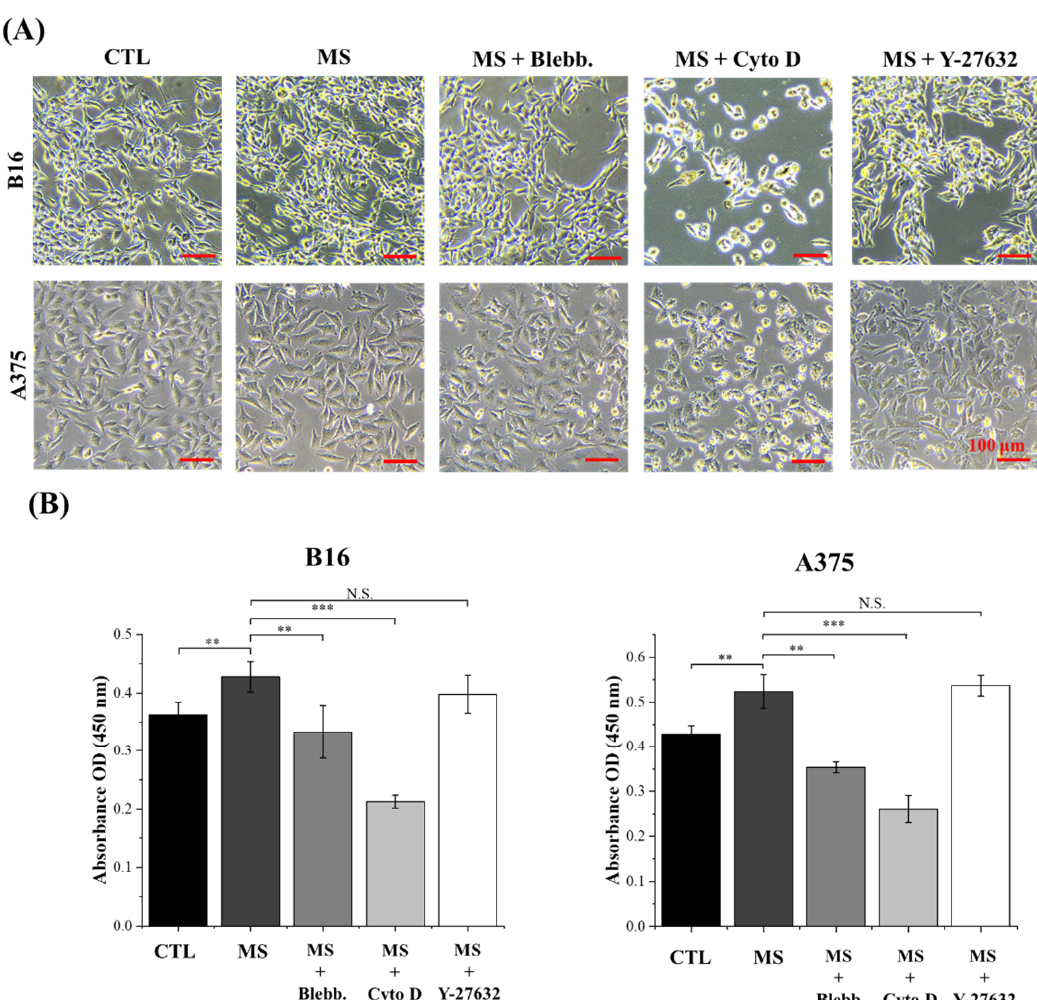
Figure 2. Influence of cyclic straining and inhibitors on melanoma cell proliferation. ( A ) Representa- tive images of melanoma cells with cyclic straining and inhibitor treatment. ( B ) Quantitative data of melanoma cell proliferation from CCK-8 assay. Data are presented as means ± SDs ( n = 3). ** p < 0.01, *** p < 0.001, N.S.: Not